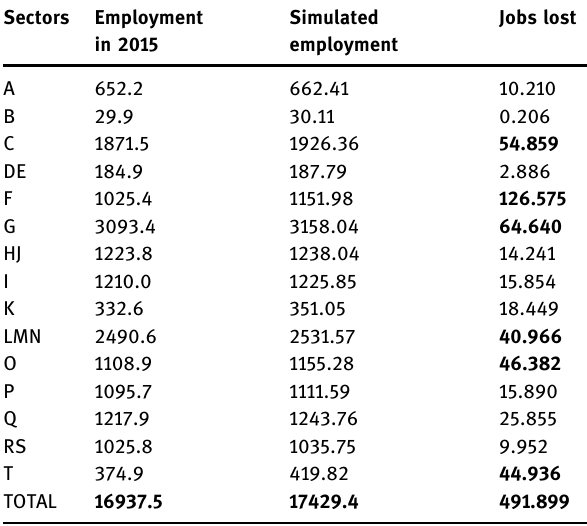
Table 5: Impact on output of shrinking employment for people aged 16 – 29 ( stated in millions of euros ) Sectors Output 2015 Simulated